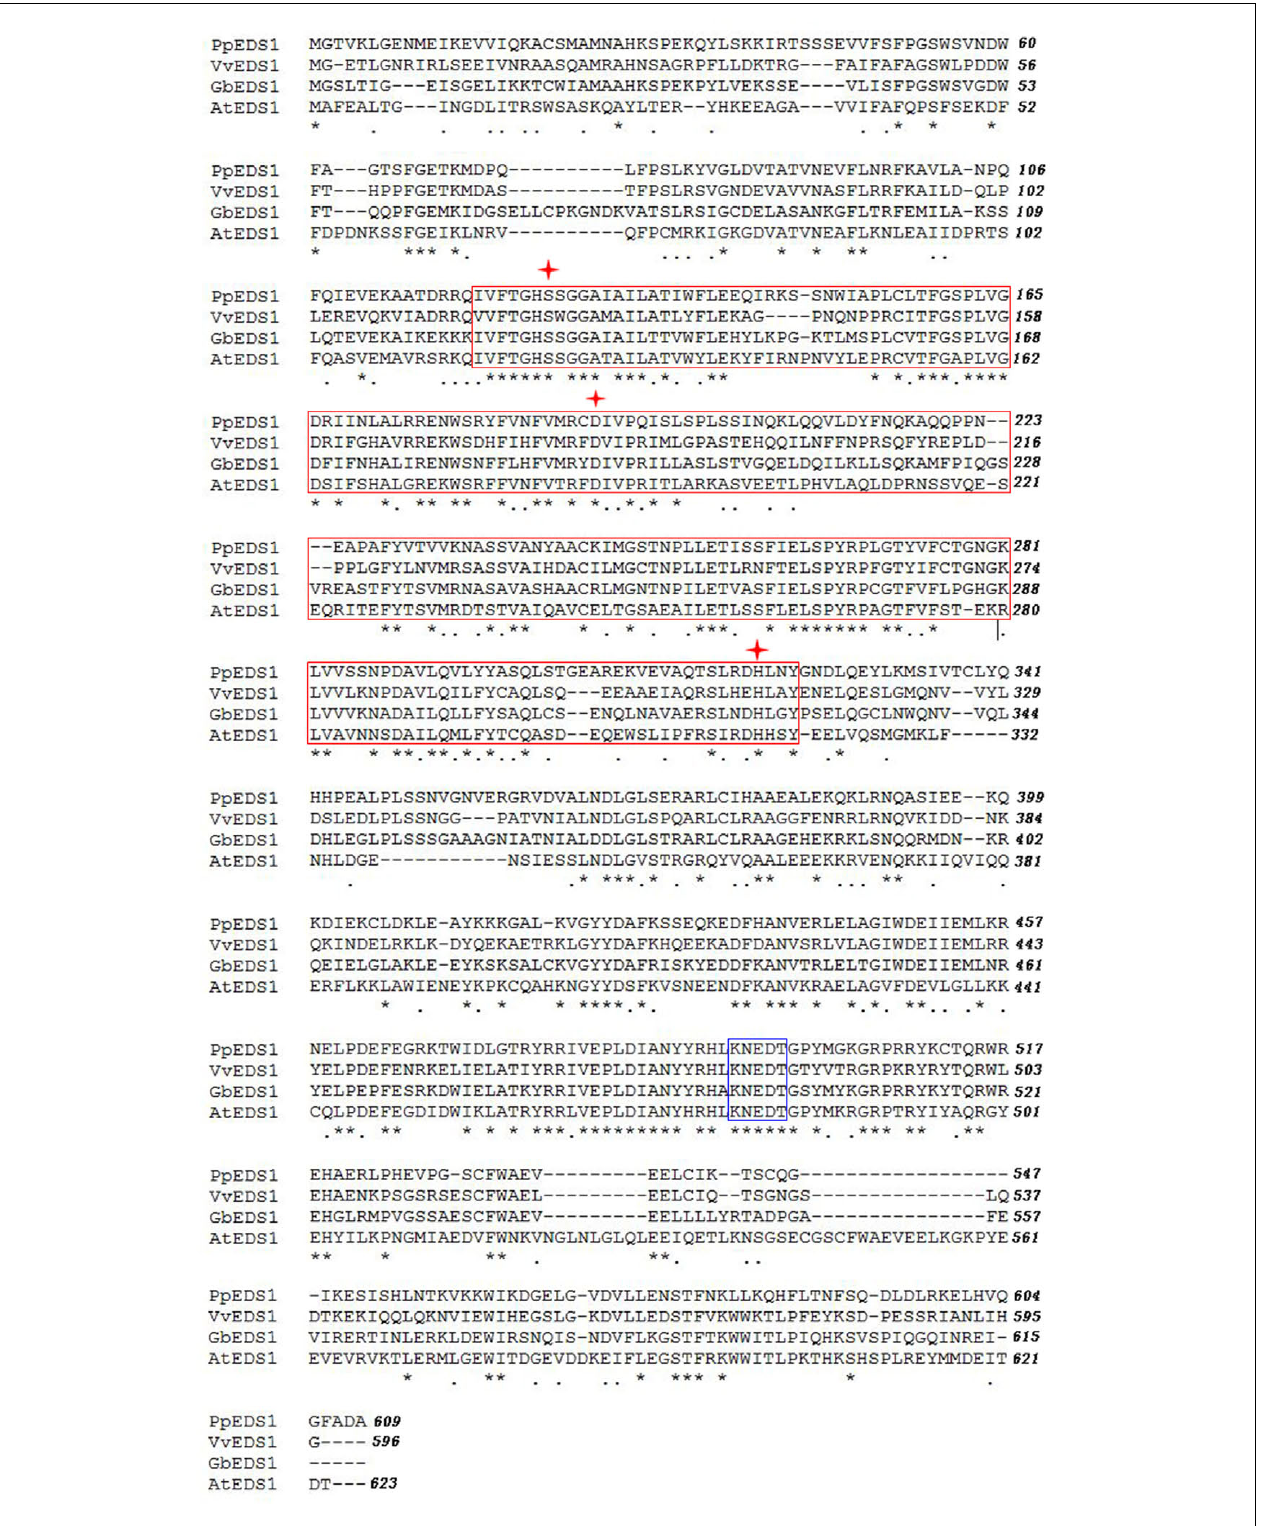
FIGURE 1 | Amino acid sequence alignment of EDS1 proteins from different plant species evaluated via ClustalW2. Putative lipase domain and EDS1-specific KNEDT motif are marked with red box and blue box, respectively. Serine (S), aspartate (D), and histidine (H) residues of putative lipase catalytic triad are indicated by asterisks. Pp, Populus poplar ; Vv, Vitis vinifera ; Gb, Gossypium barbadense ; and At, Arabidopsis thaliana .